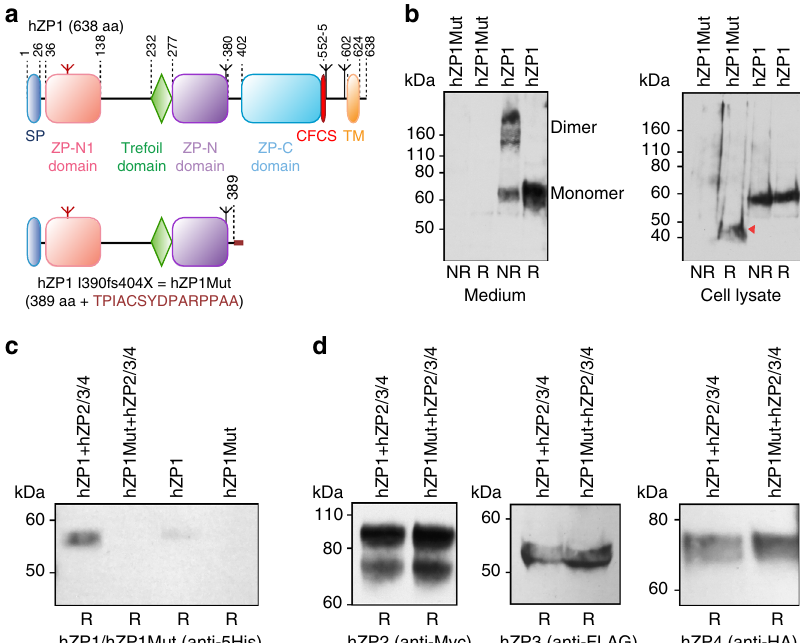
Fig. 1 ZP1 I390fs404X mutant protein does not affect the secretion of hZP2-4. a Domain architecture of wild-type and mutant hZP1. SP signal peptide, CFCS consensus furin cleavage site, TM transmembrane domain. Inverted tripods mark N-glycosylation sites, with the conserved N-glycan of the ZP-N1 domain coloured red. Domain boundaries are indicated, and the 15-residue C-terminal extension resulting from the frameshift mutation is highlighted in dark red. b Anti-5His immunoblots of medium (left; 2.4 mL per lane) and cell lysate (right; 0.3 mL per lane) samples from HEK293T cells expressing hZP1 constructs show that hZP1Mut is retained intracellularly (red arrow). NR non-reducing conditions, R reducing conditions. c Co-expression with human ZP2- 4 increases secretion of wild-type hZP1, but does not rescue secretion of hZP1Mut (240 μ L medium per lane). d The secretion levels of hZP2, hZP3 and hZP4 do not change upon co-expression with either hZP1 or hZP1Mut (240 μ L medium per